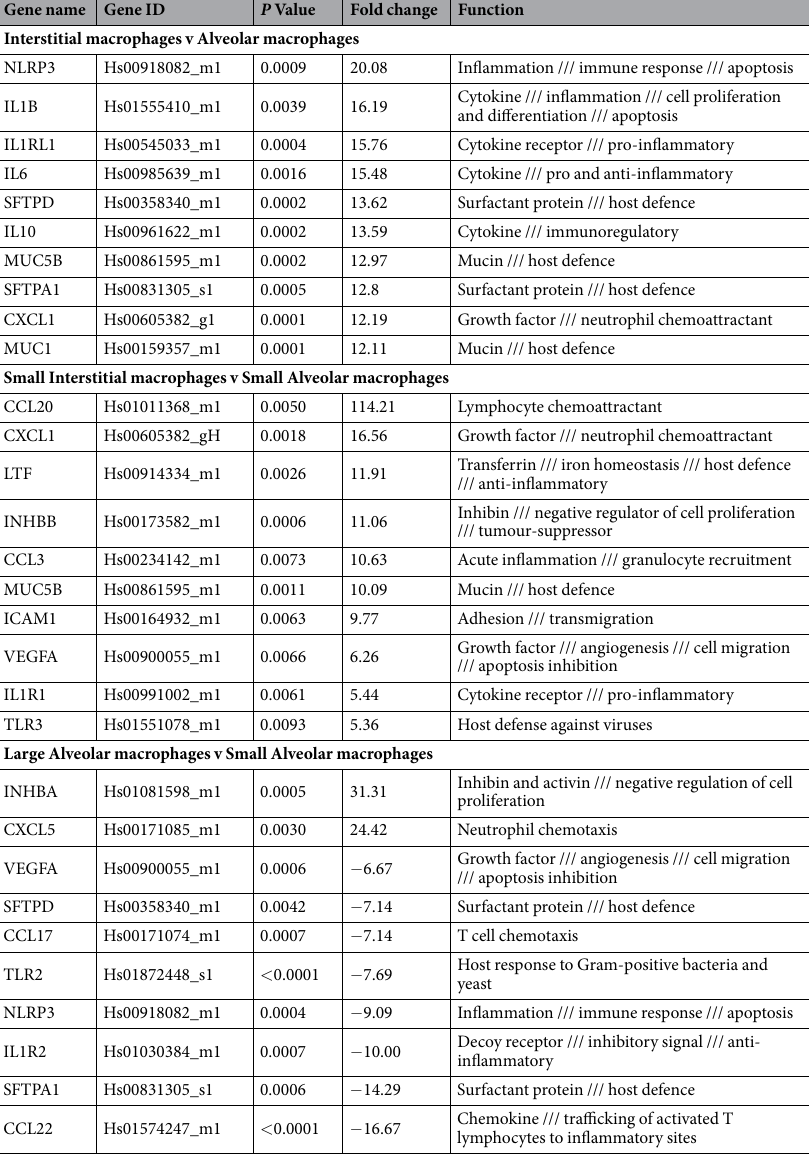
Table 2. Genes showing significantly different expression in whole interstitial, small interstitial and large alveolar macrophages from COPD patients. The 10 most highly up and down regulated genes are shown. The full lists of genes are shown in Tables S9, S11 and S12. Macrophage mRNA was analysed using a Custom Made Taqman Assay and data was analysed with whole alveolar macrophages or small alveolar macrophages as the reference. Paired t test (two tailed) was performed and p < 0.01 for all